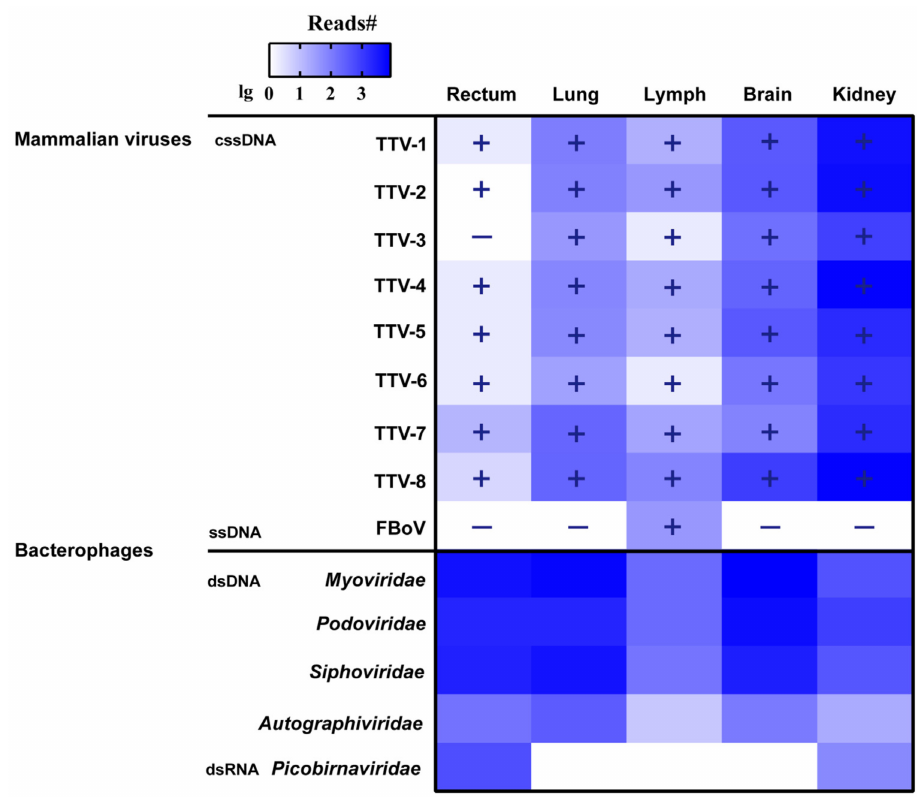
Figure 1. Overview of the virome profiling and the PCR detection of the Amur leopard cat . The heatmap shows the read numbers of these viruses in the five samples. The plus and minus symbols indicate the results of PCR detection. cssDNA: circular single-stranded DNA viruses; ssDNA: linear single-stranded DNA viruses; dsDNA: double-stranded DNA viruses; dsRNA: double-stranded RNA viruses; TTV: torque teno